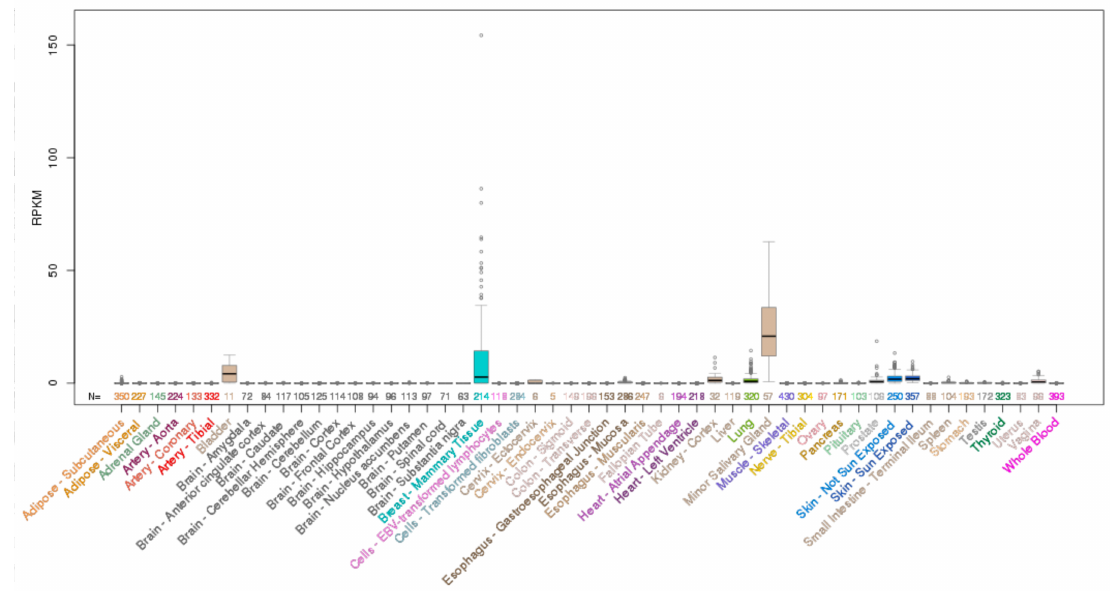
Figure 4. Expression of ELF5 mRNA across normal human tissues. Data obtained from UCSC genome